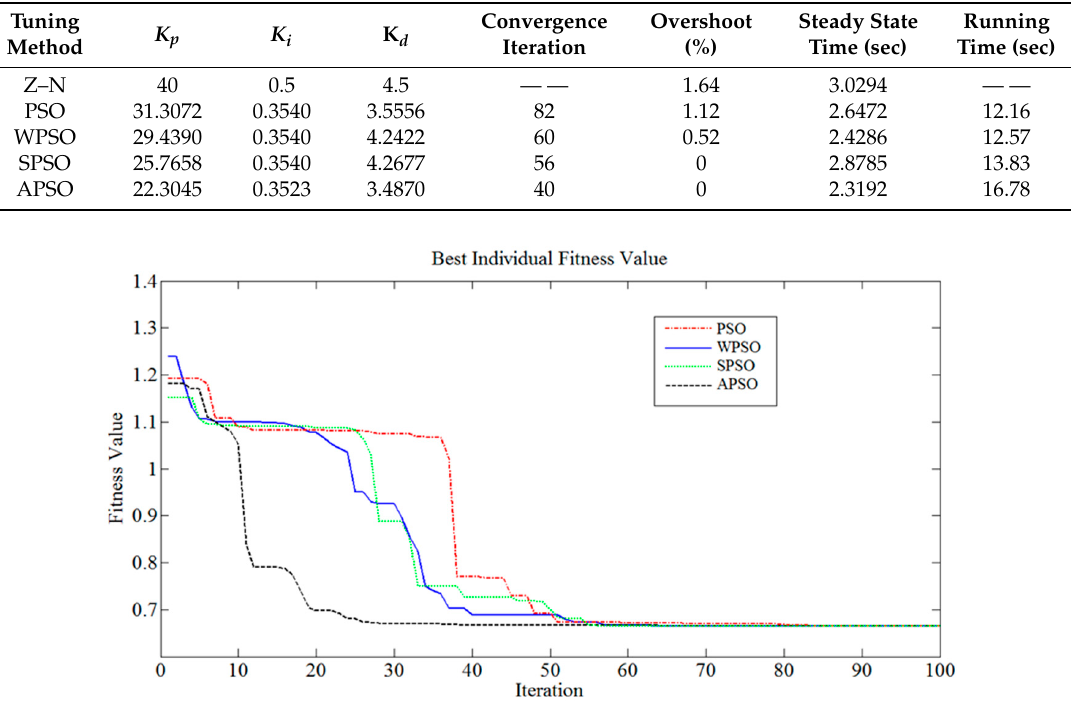
Figure 6. Comparison between the fitness curves of the simulations.